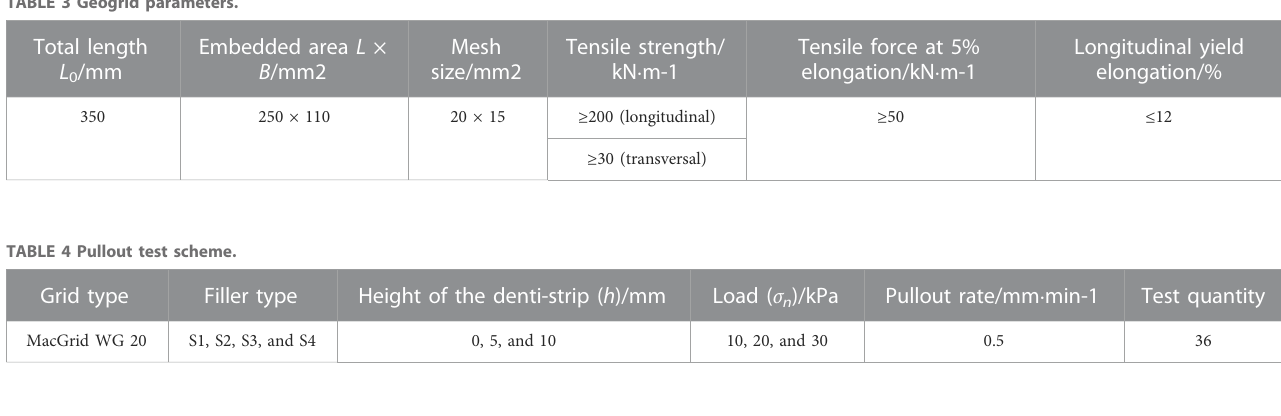
TABLE 3 Geogrid parameters.